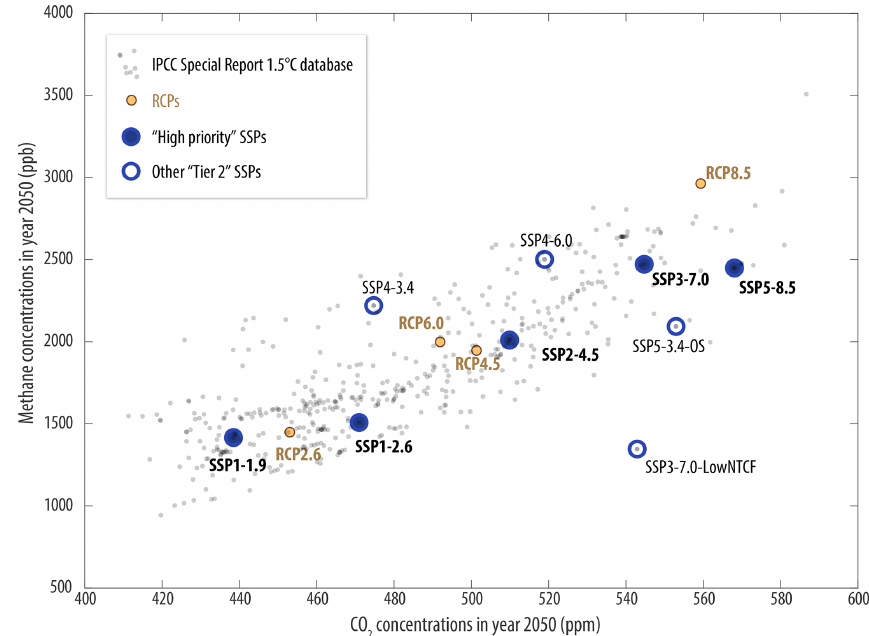
Figure 9. The 2050 CO 2 and CH 4 concentrations of SSPs (dark-blue circles), RCP (orange circles), and scenarios of the IPCC Special Report on 1.5 ◦ C warming database (grey dots). All scenarios’ concentrations were derived by using the SSP or RCP or SR1.5 harmonized emission scenarios together with the same MAGICC7.0 default settings as used for the CMIP6 SSP concentration